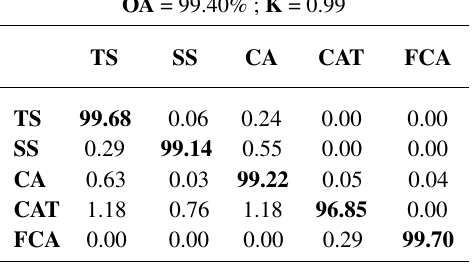
Table 10. Confusion matrix September 2018